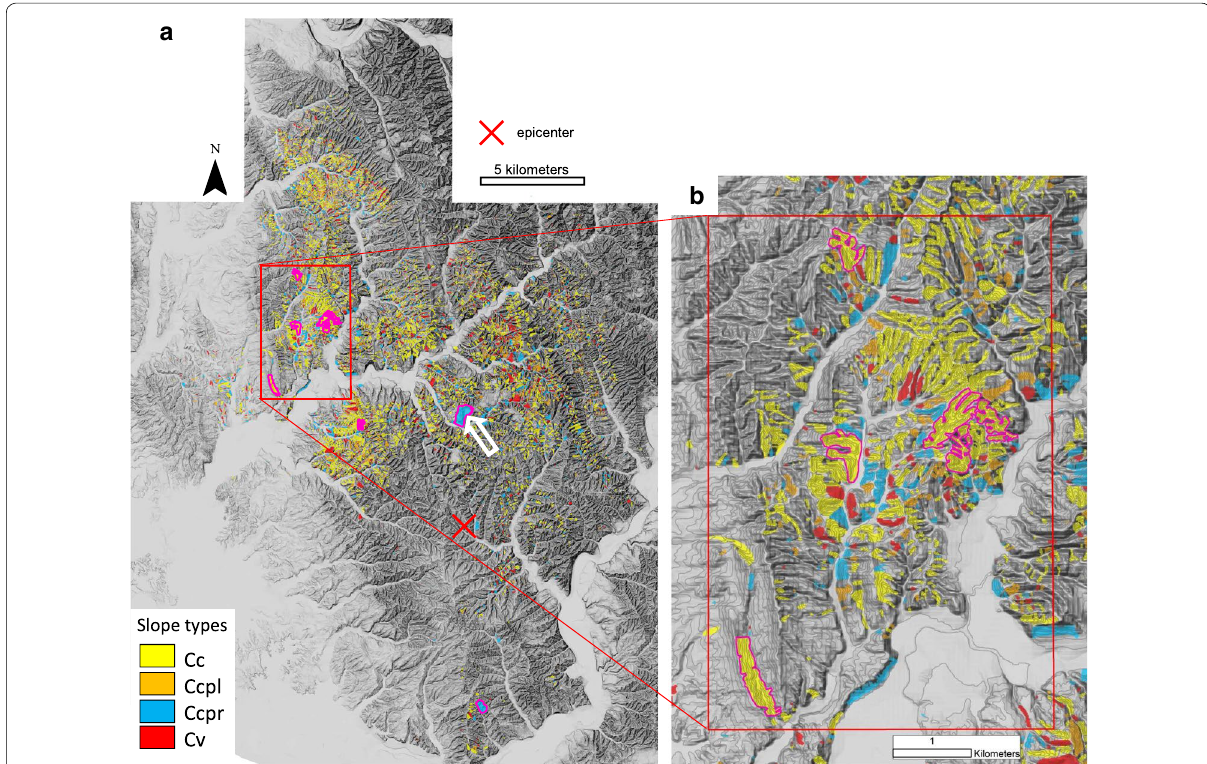
Fig. 13 a Distribution of landslides with slope type. Landslides larger than 10 5 m 2 are outlined in pink. White arrow indicates the landslide that formed a dam. b Enlarged image of the area enclosed in red in a . The original inventory was produced by Kita (2018)